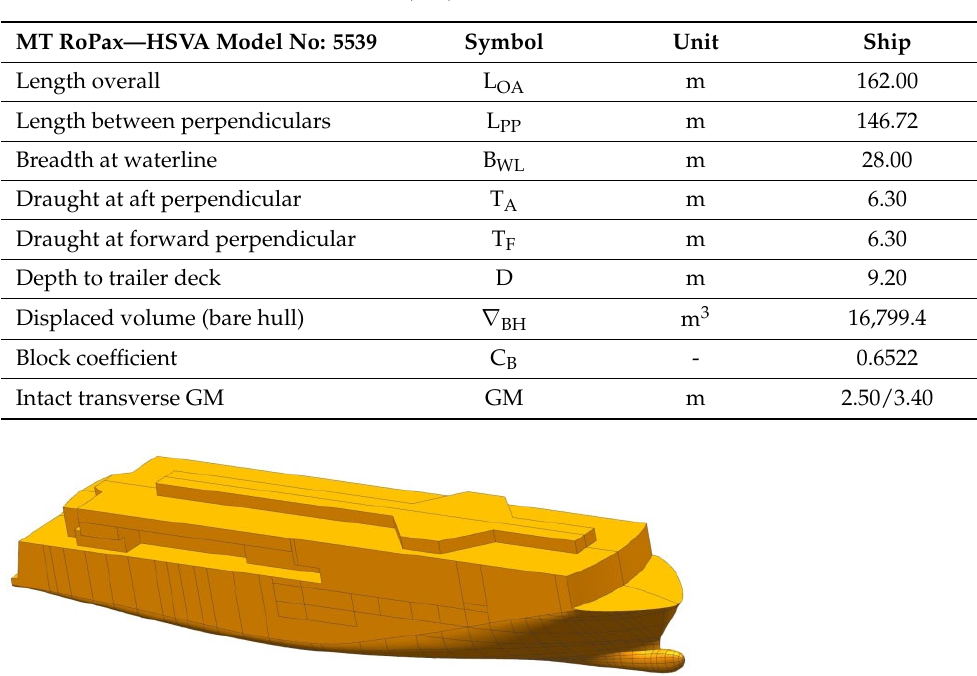
Table 1. Main data of the vessel in intact (test) condition.